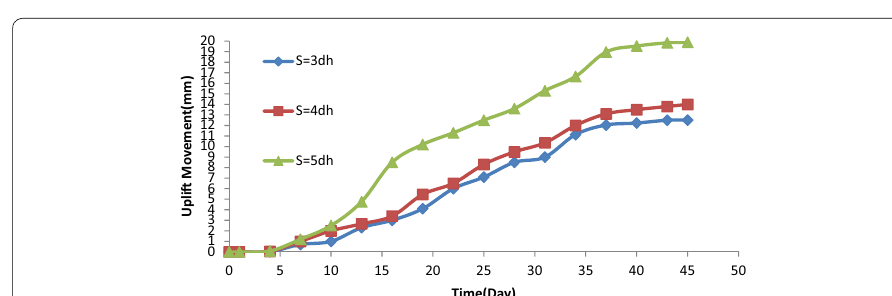
Fig. 26 Variation of uplift movement with time for pile group of L/D